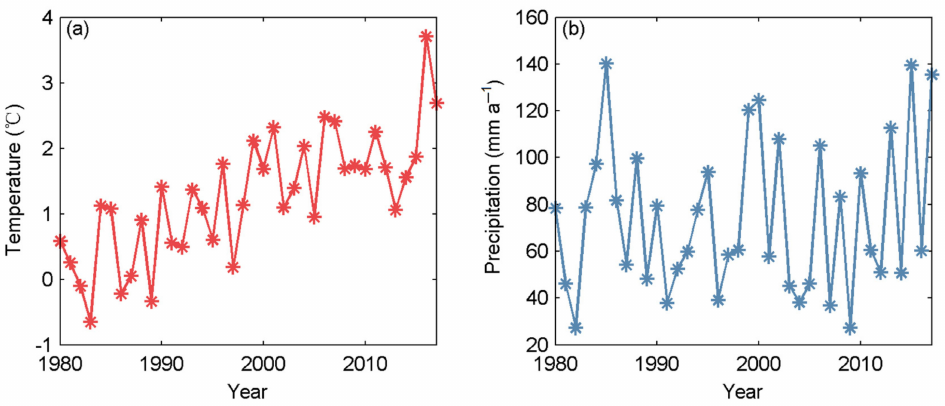
Figure 2. Annual mean temperature ( a ) and precipitation ( b ) records at the Shiquanhe station from 1980 to